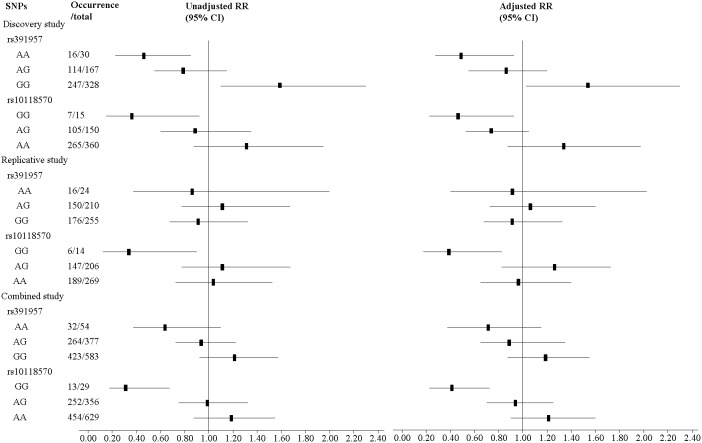
Association results of two SNPs with risk of hepatic fibrosis in chronic S. japonicum infected adults in the discovery, replication and combined studies.Unadjusted RR was calculated using Pearson Chi-square test. Adjusted RR was adjusted for age, gender, smoking, drinking and HBsAg. d, the deleted base.